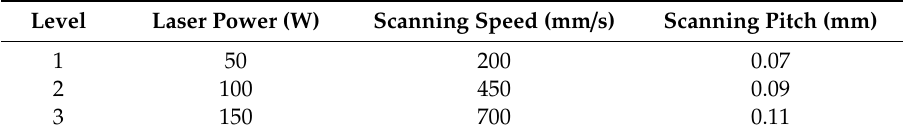
Figure 3. Schematic diagram of orthogonal test design. Table 1. Factors and levels for orthogonal test